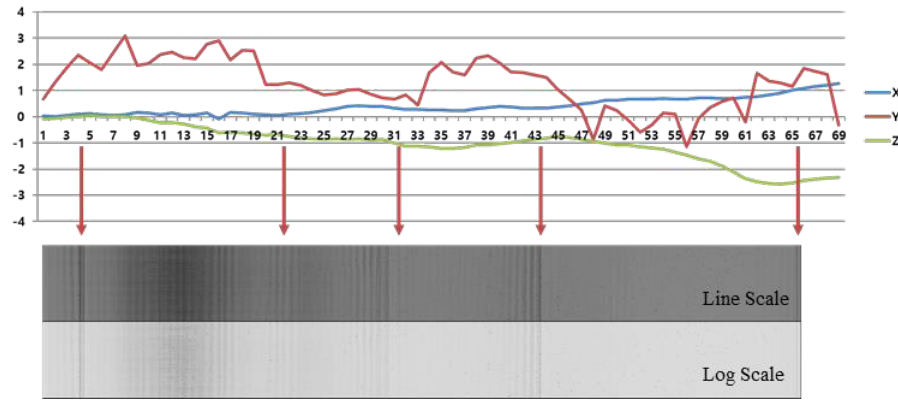
Figure 9. Image of x -, y -, and z -axis misalignment for the R1 and R2 robots.